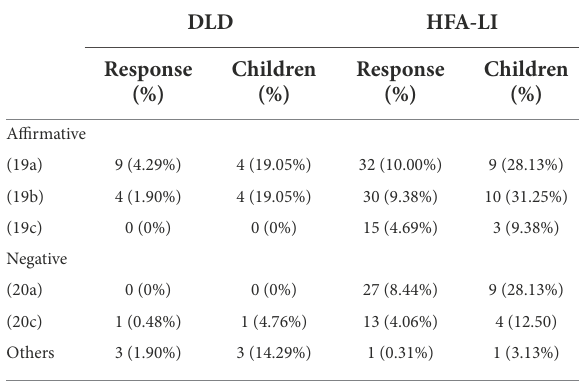
TABLE 6 Number of non-target responses in Structure